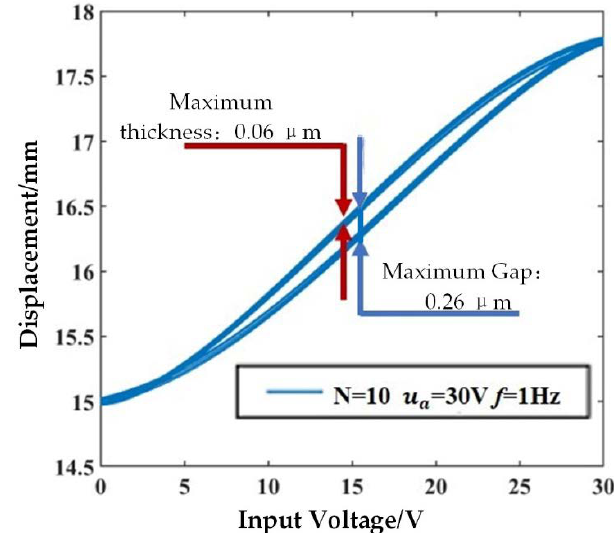
Figure 5. Hysteresis curve of piezoelectric sensor-actuator.